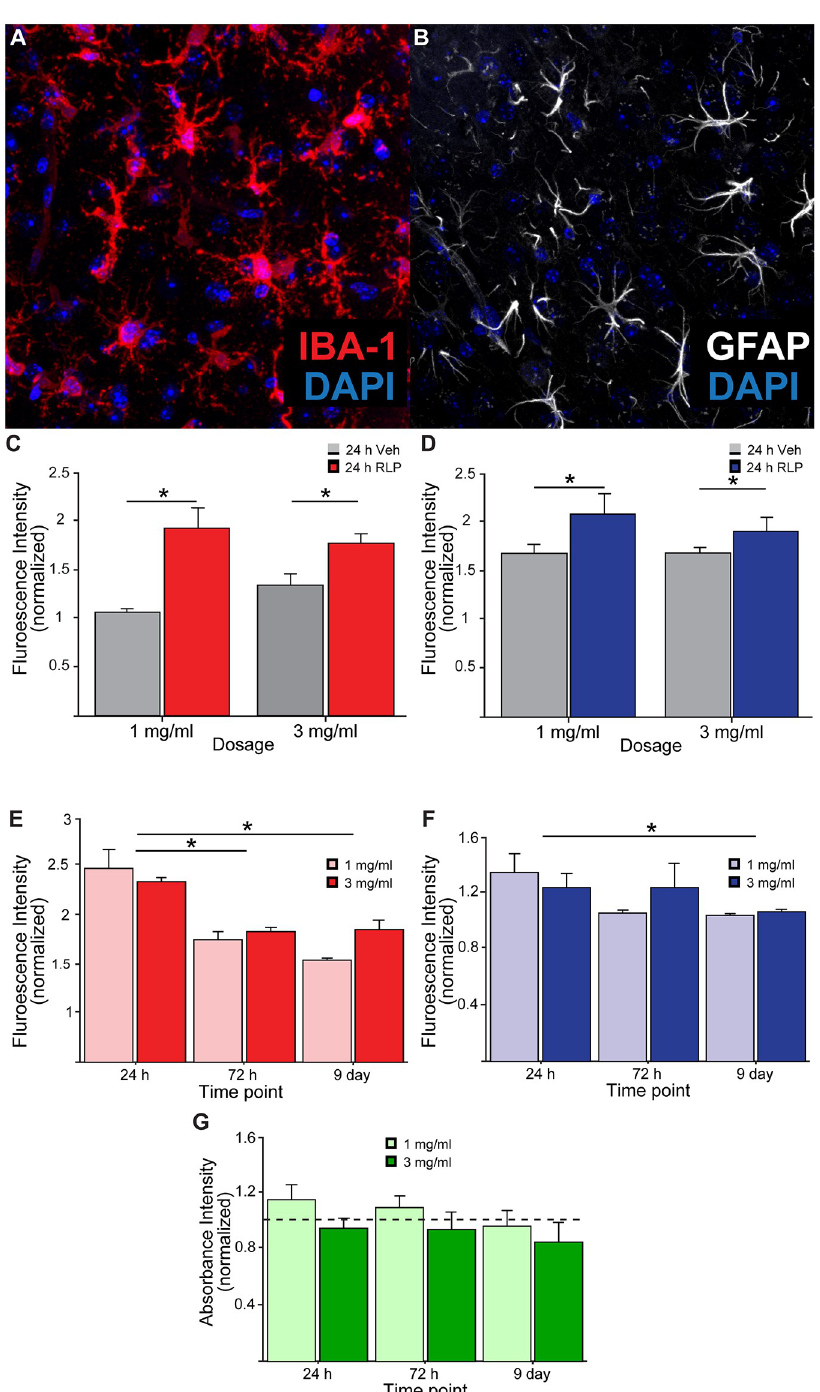
Fig 5. Quantifying immune cell presence adjacent to radioluminescent particle injections. A) Representative image of IBA-1 + microglia and B) GFAP + astrocytes near RLP injection site. C) Fluorescence intensity of IBA-1 and D) GFAP staining in vehicle (saline) versus RLP-injected M2 following injections of 1mg/ml and 3mg/ml in mice sacrificed 24 hours after injection. E) Total fluorescence intensity of IBA-1 and F) GFAP in RLP-injected M2 (normalized to vehicle-treated contralateral hemisphere) for animals receiving 1 and 3 mg/ml concentrations of RLPs 24 hours, 72 hours, and 9 days post-injection. (G) In vitro Alamar blue assay revealed no significant changes in cell viability of cultured neurons following RLP exposures at multiple timepoints compared to untreated controls (dashed line at “1”).